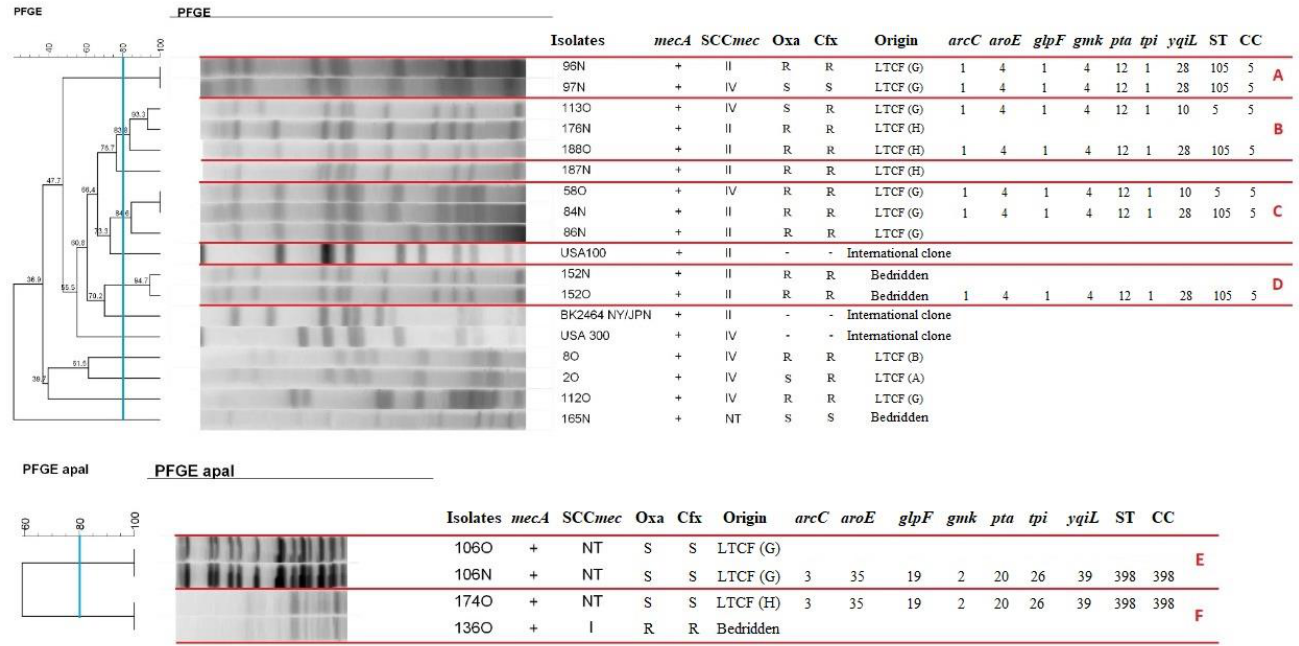
Figure 4. Dendrogram of PFGE- SmaI and PFGE- ApaI profiles of MRSA isolated from bedridden patients or institutionalized individuals generated by Dice analysis/UPGMA (BioNumerics, Applied Maths) and sequence types (ST) obtained by MLST. Note: Resistant isolates forming clusters >80% similarity